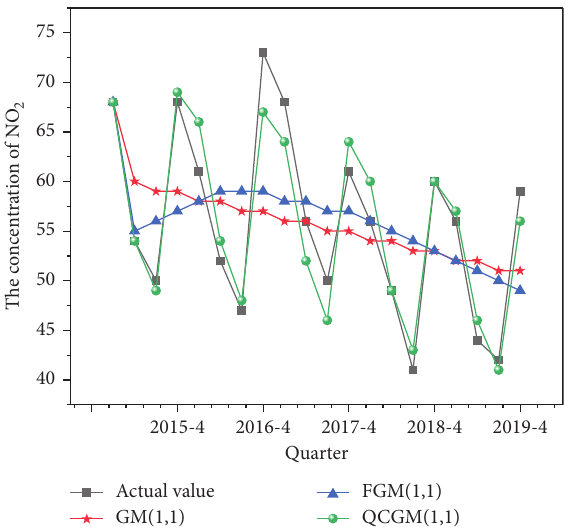
Figure 1: The fitting results of NO 2 concentration by three models in